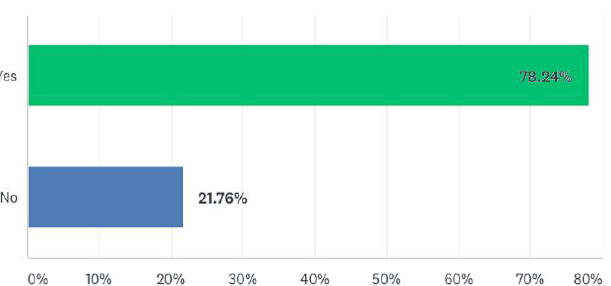
Figure 8. U.S. participants’ willingness to pay—support locally sourced food/farming industry.